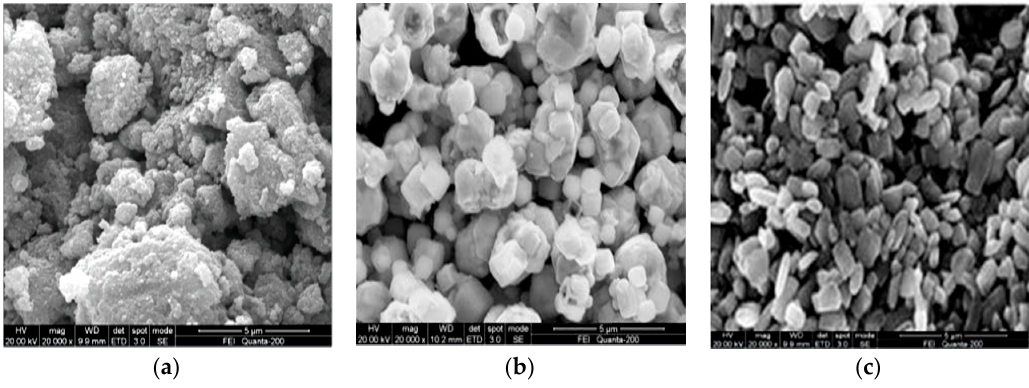
Figure 6. SEM images of ( a ) C0 catalyst; ( b ) activated catalyst; and ( c ) fresh catalyst.